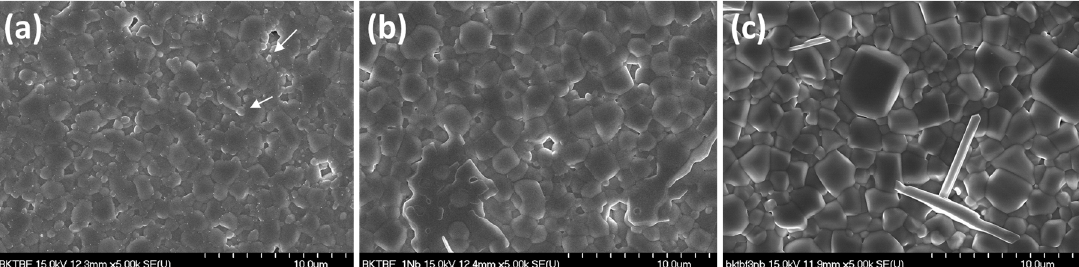
Figure 3. SEM micrographs of: 0.4(K 0.5 Bi 0.5 )Ti (1 − x ) Nb x O 3 ‐ 0.6BiFe (1 − x ) Nb x O 3 samples after sintering at 1050 °C for 1 h: ( a ) x = 0.00; ( b ) x = 0.01 and ( c ) x = 0.03.